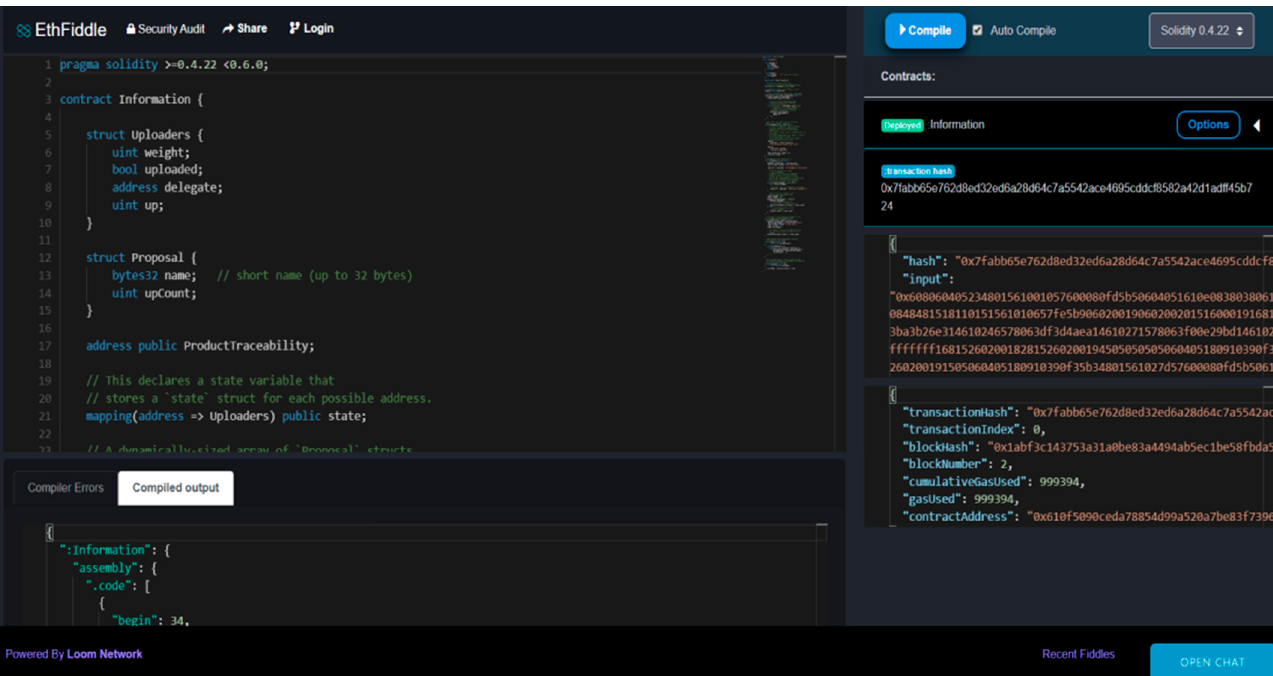
Figure 7. Info smart contract compilation results.